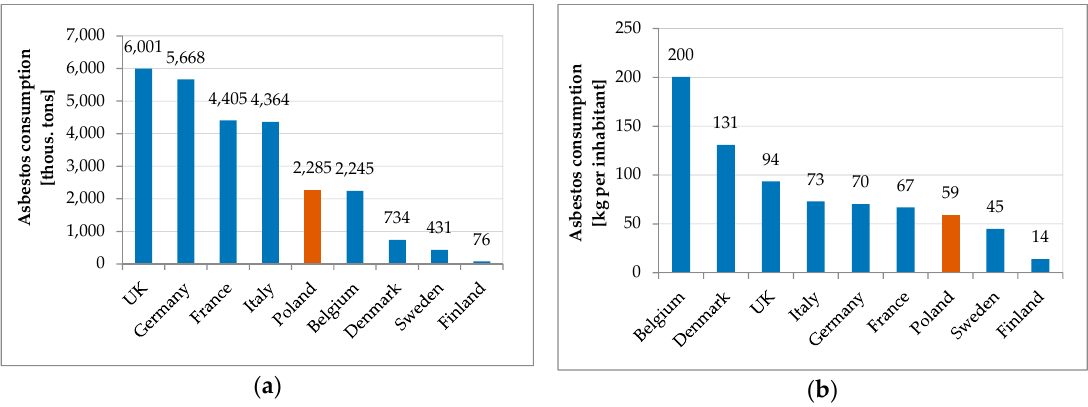
Figure 2. Asbestos consumption in selected European countries. ( a ) Total consumption (thousand tons); ( b ) Total consumption per capita (kg per person).